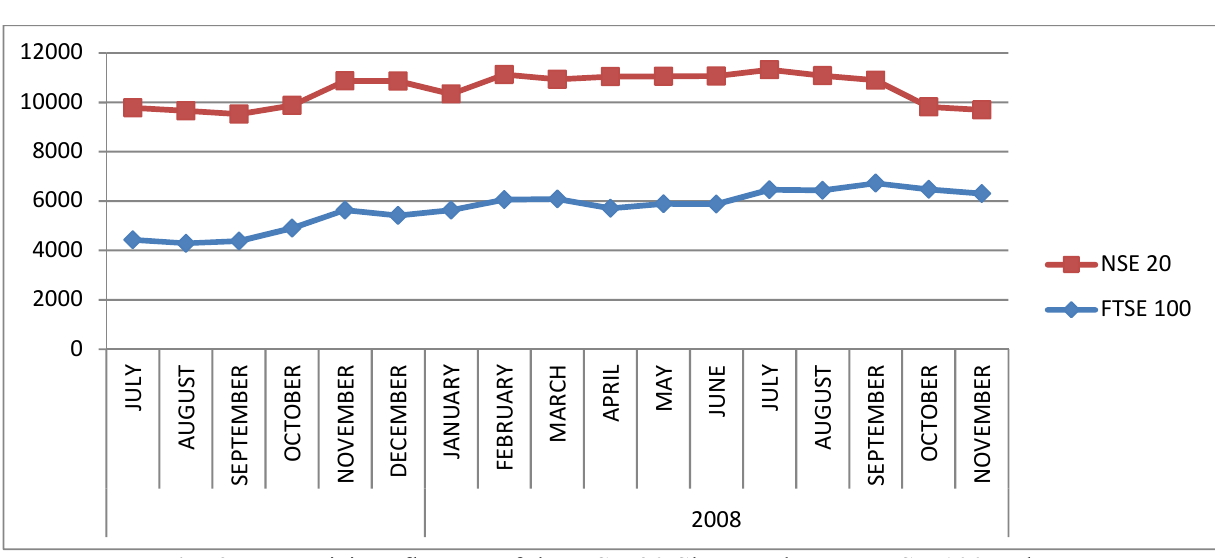
Fig. 3. Post crisis Influence of the NSE 20 Share Index on FTSE 100